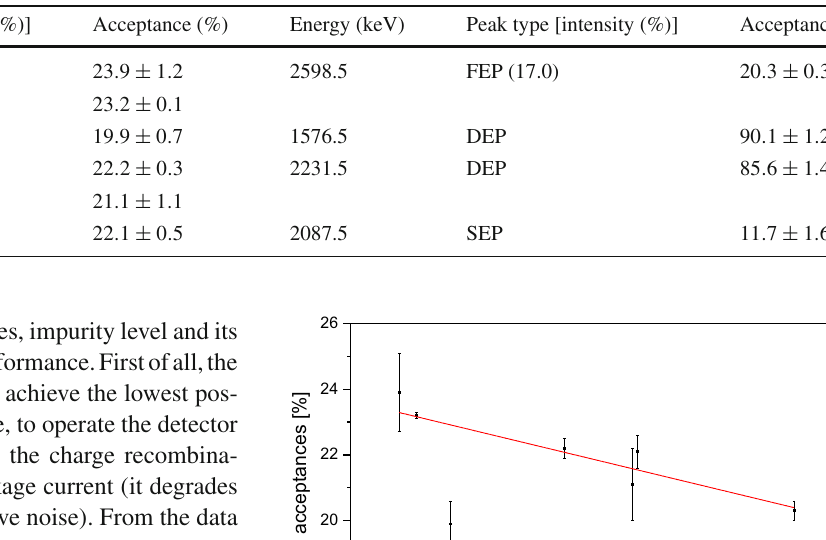
Table 2 Acceptancesofevents invarious peaks present inthe 56 Cospectrum. Training ofthe neural network wasperformed on 228 Th data assuming 90% survival efficiency of the 1592.5keV DEP